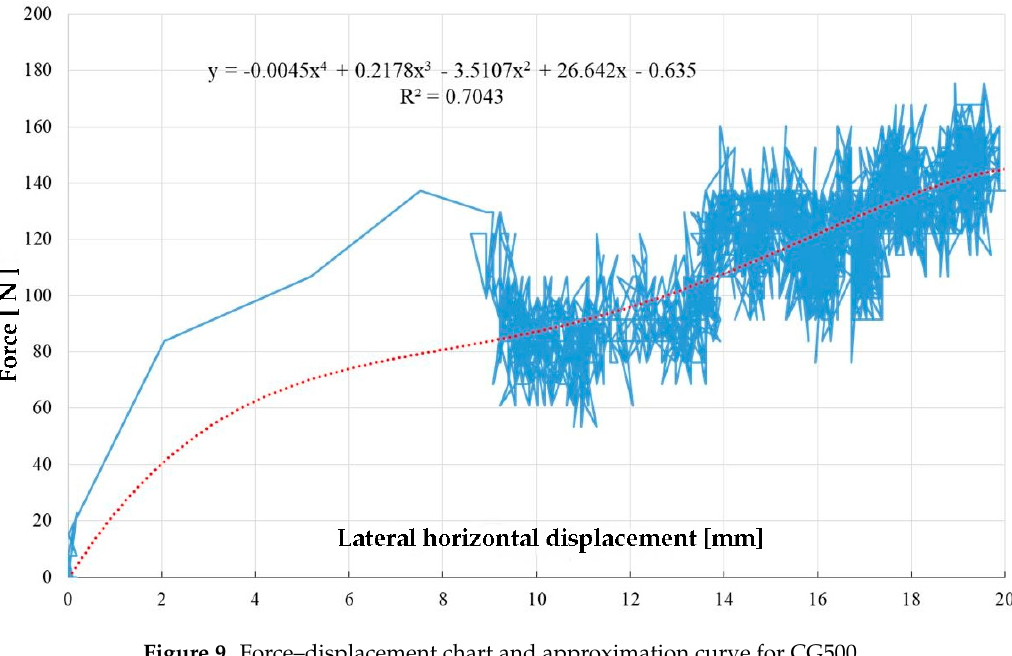
Figure 9. Force–displacement chart and approximation curve for CG500.